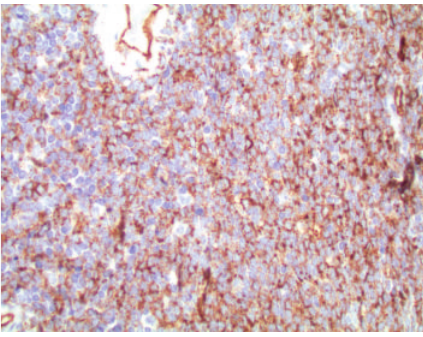
Figure 8: Fluorescence in situ hybridization assay on vitreous humor smear shows two BCR-ABL1 fusion signals, one BCR probe signal, and two ABL1 probe signals; thus a t(9;22) BCR-ABL1 gene rearrangement with gains of 9 and 22 [orange = 9q34 ABL1 probe; green = 22q11.2 BCR probe].